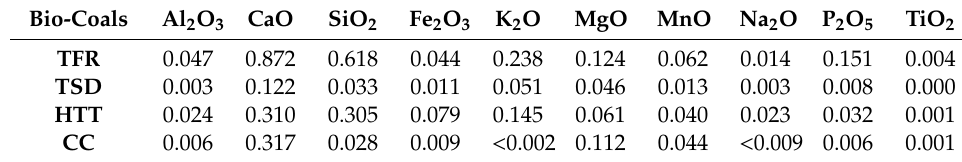
Table 4. Contents of metal oxides in the bio-coal materials (wt %, dry basis)